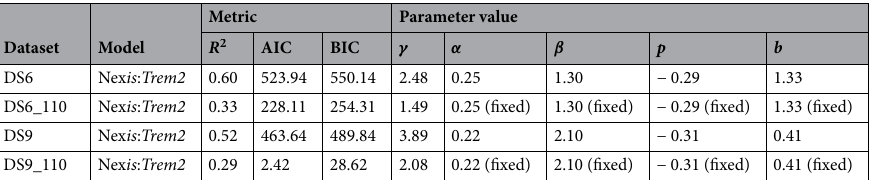
Table 2. Effect of dilute lysates. Nex is : Trem2 model parameters for α , β , p , and b obtained for DS6 and DS9 were applied to Nex is : Trem2 for 1:10 diluted versions of those dataset (i.e. DS6_110 and DS9_110). Seed rescale parameter ( γ ) was allowed to be fit for DS6_110 and DS9_110. Nex is : Nexopathy in silico , AIC: Akaike’s Information Criteria, BIC: Bayesian Information Criteria, R 2 : model fit parameter, γ : seed rescale parameter; α : intra-regional tau accumulation rate; β : inter-regional tau spread rate; p : microglia-mediated intra-regional tau accumulation rate; b : microglia-mediated inter-regional tau spread rate. The word ’fixed’ in parentheses means that this parameter has been fixed to that obtained for DS6 and DS9 while running the model to fit only the γ parameter in DS6_110 and DS9_110, respectively.